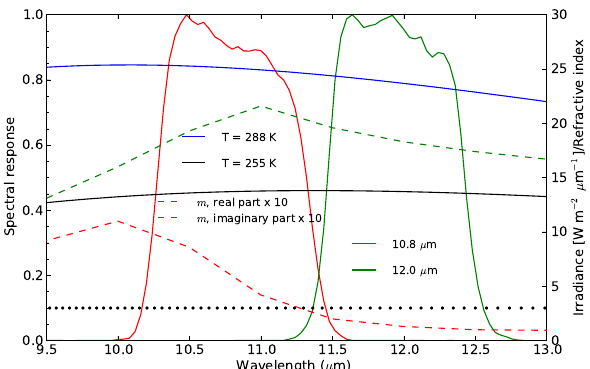
Fig. 2. The spectral responses for the 10.8 (red line) and 12.0µm (green line) channels of the SEVIRI instrument. The Planck distri- bution for two temperatures is shown in black and blue. The real and imaginary part of the refractive index m of andesite from Pol- lack et al. (1973) are showed in red and green dashed lines, respec- tively. The dotted black line illustrates the wavelength grid of the LOWTRAN parameterization (Pierluissi and Peng, 1985; Ricchi- azzi et al.,